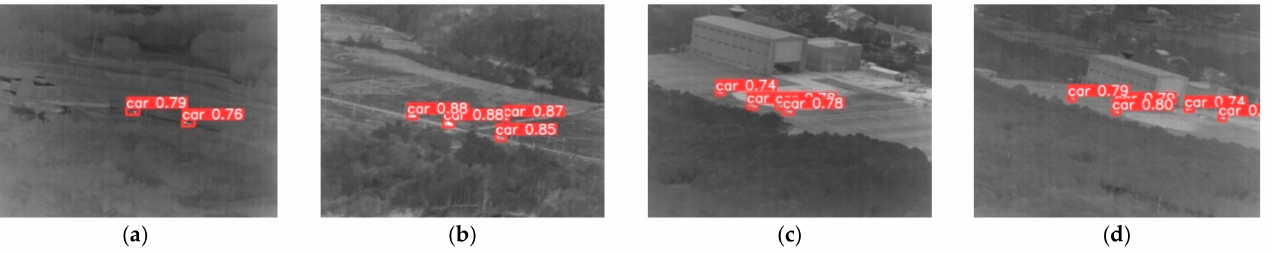
Figure 12. Ghost convolutional test results. ( a ) Scene 1. ( b ) Scene 2. ( c ) Scene 3. ( d ) Scene 4.